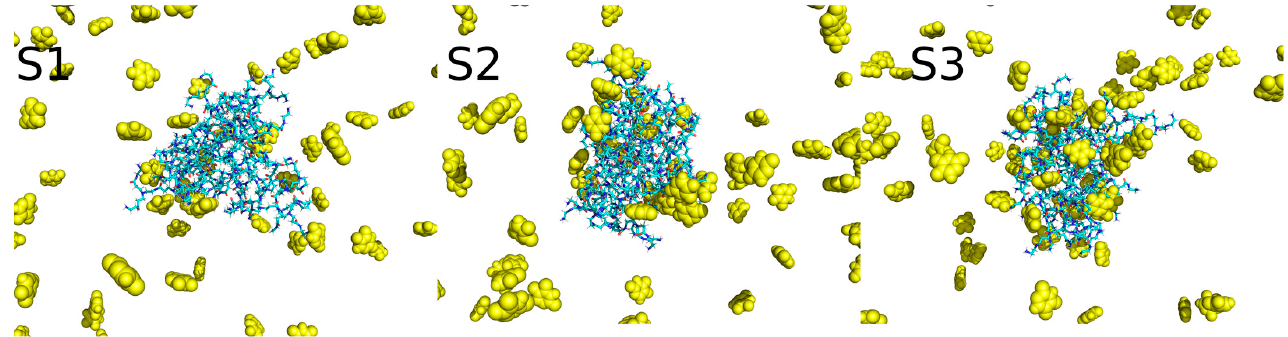
Figure 5. Final structures of the mixed systems: dendrimer (blue) and 100 5FU molecules (yellow).